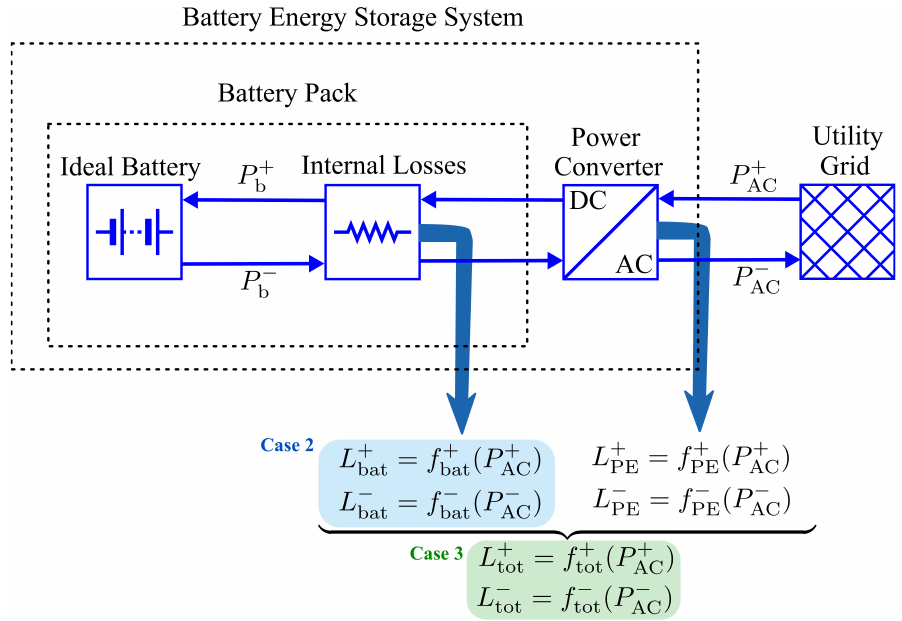
Figure A7. System